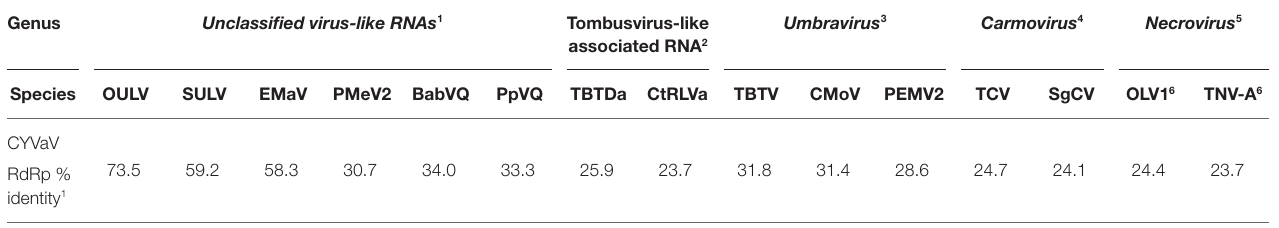
TABLE 1 | Sequence identities of pairwise comparisons of complete amino acid sequence of RNA-dependent RNA polymerase (RdRp) of citrus yellow-vein associated virus (CYVaV) with phylogenetically related members of the family Tombusviridae . Genus